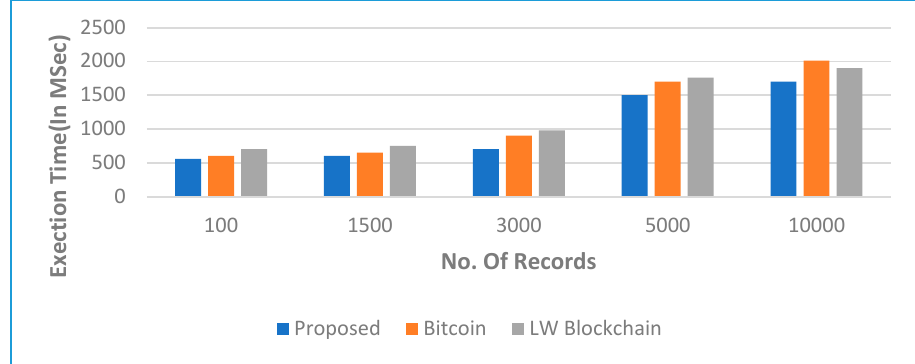
Figure 12. According to the execution time and number of medical records, the simulated outcomes.